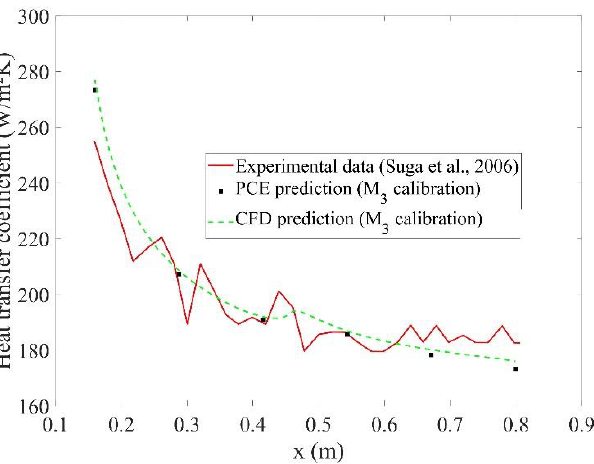
Figure 10. PCE and CFD predictions using M 3 calibrated values (Bayesian inversion).